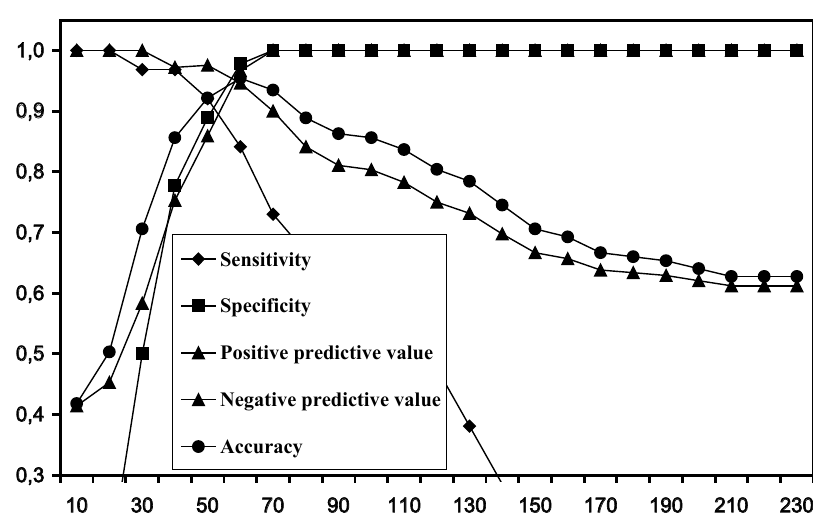
Fig. 2. Enddiastolic velocity in the internal carotid